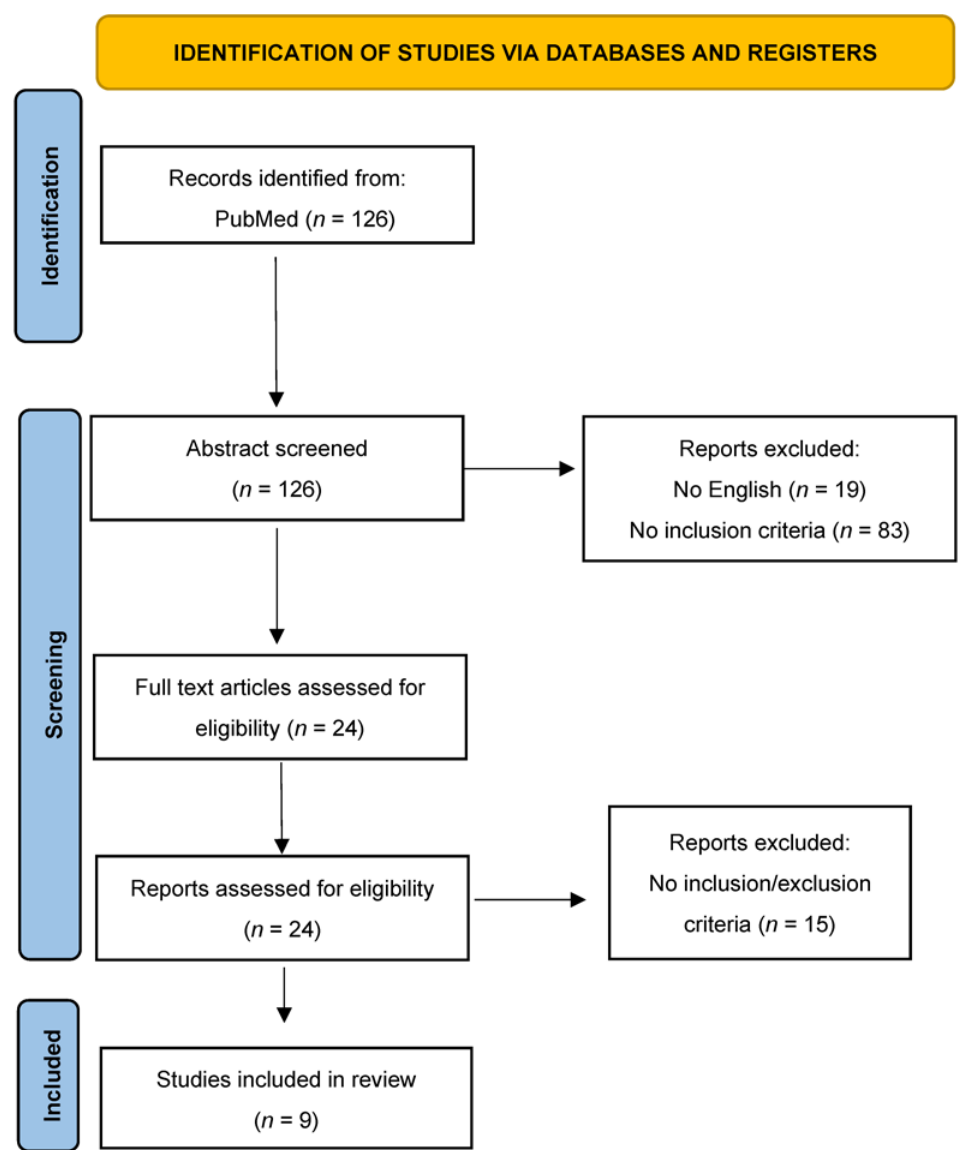
Figure 2. Search strategy: a methodological appraisal of each study was conducted according to the PRISMA standards, including an evaluation of bias. The data collection process included study selection and data extraction .